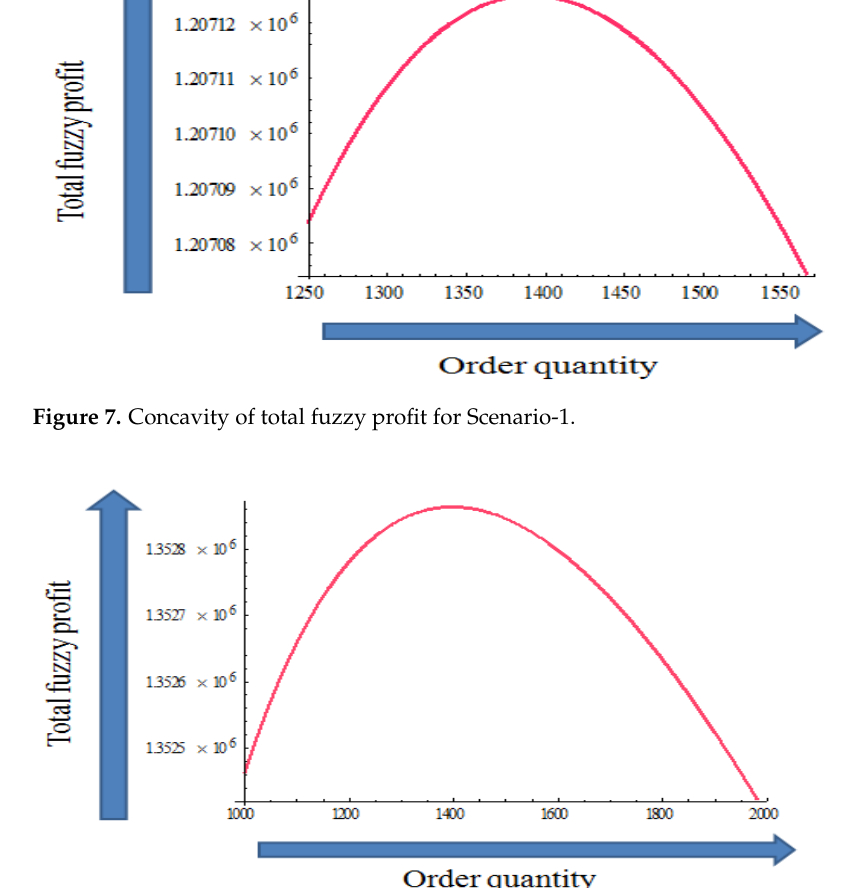
Figure 8. Concavity of total fuzzy profit for Scenario-2.